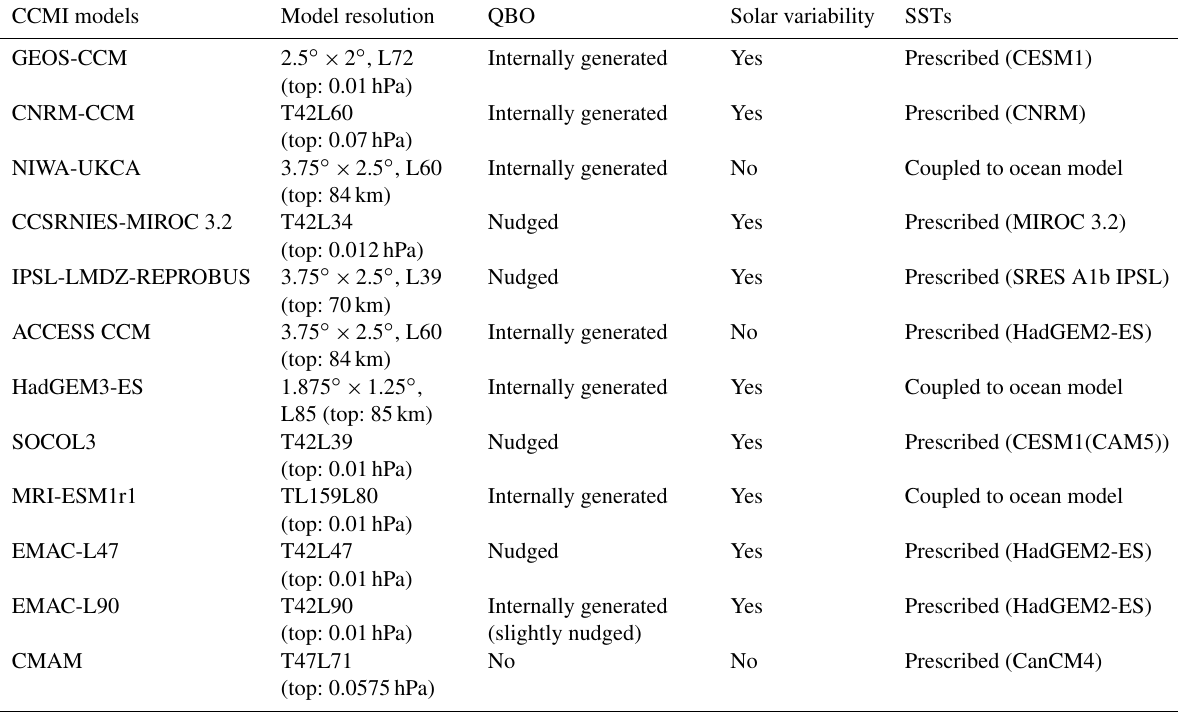
Table 1. Main characteristics relative to the models and their REF-C2 simulations used in this